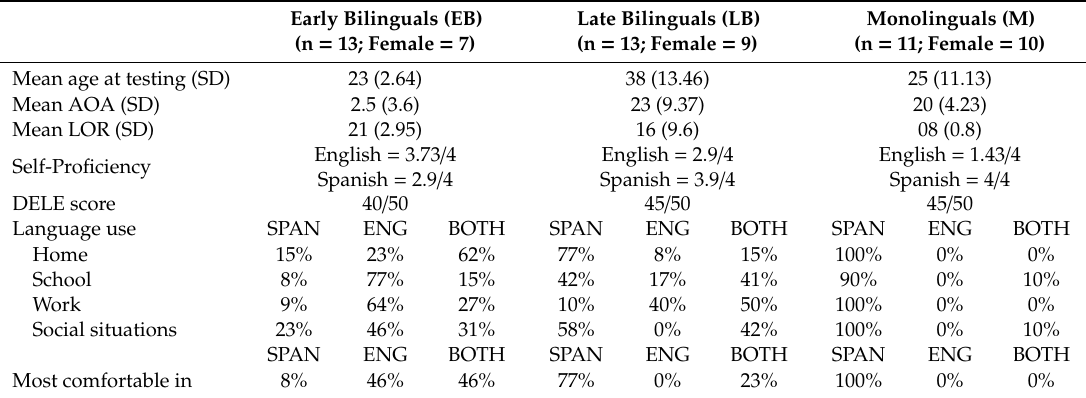
Table 1. Participants’ demographic